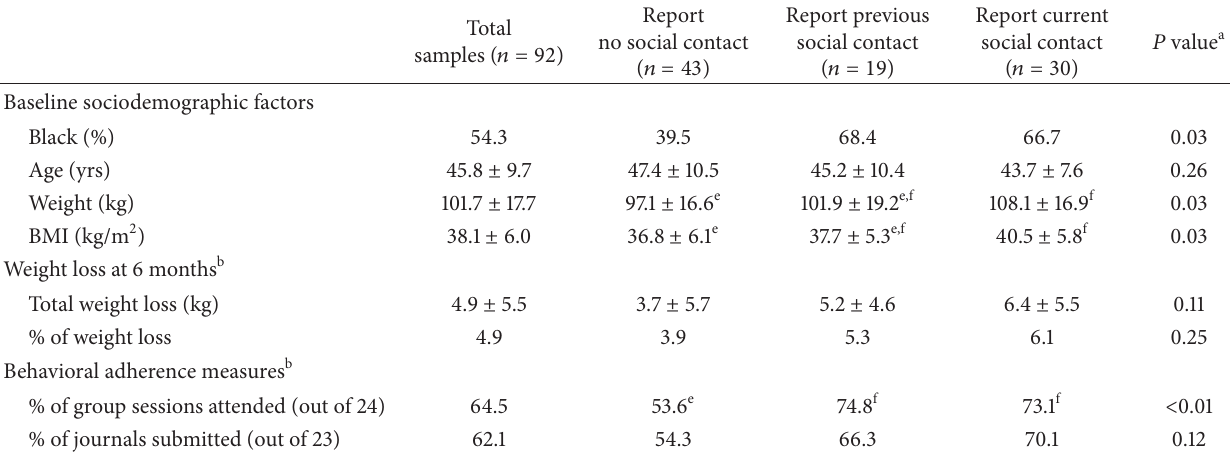
Table 1: Characteristics of study sample ( 𝑛 = 92 ).